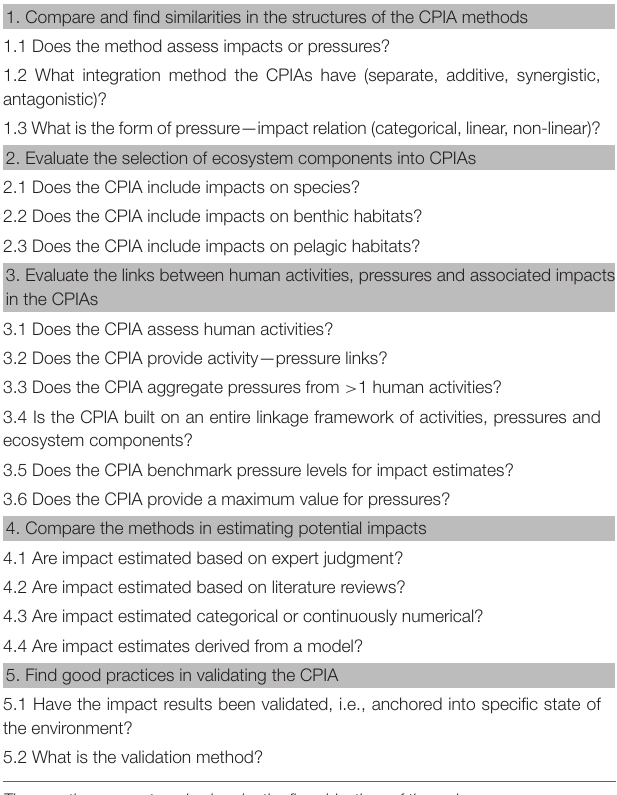
TABLE 1 | Specific research questions in the